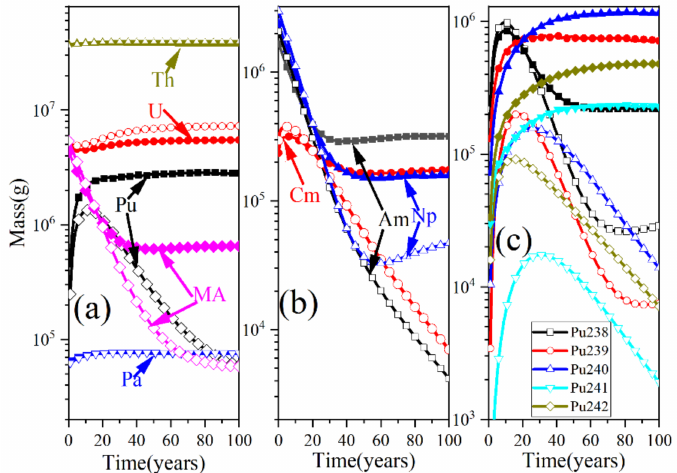
Figure 6. Evolution of the main heavy nuclides ( a ), MA ( b ), and Pu ( c ) for scenario 1 (empty dot lines) and scenario 2 (solid dot